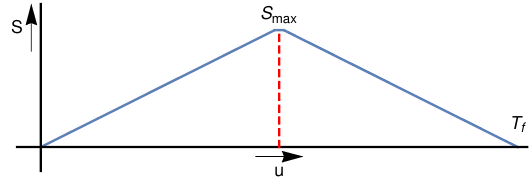
Figure 2: The naive Page curve. If one incorrectly assumes that the Hilbert space fac- torizes into degrees of freedom outside and inside the black hole, the von Neumann entropy of the radiation that has emerged till retarded time u on obey the curve above indicating that “information is gradually returned to the exte- rior.”